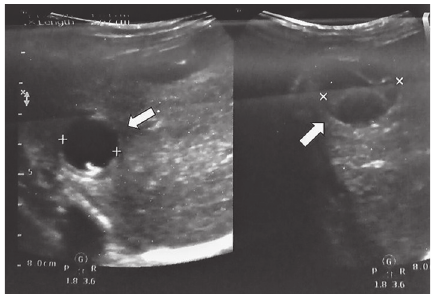
Figure 2: US scan of the patient no.3 before treatment: cysts in S7/8 (on the left), a cyst with fibrinous septum in the left lobe of the liver (on the